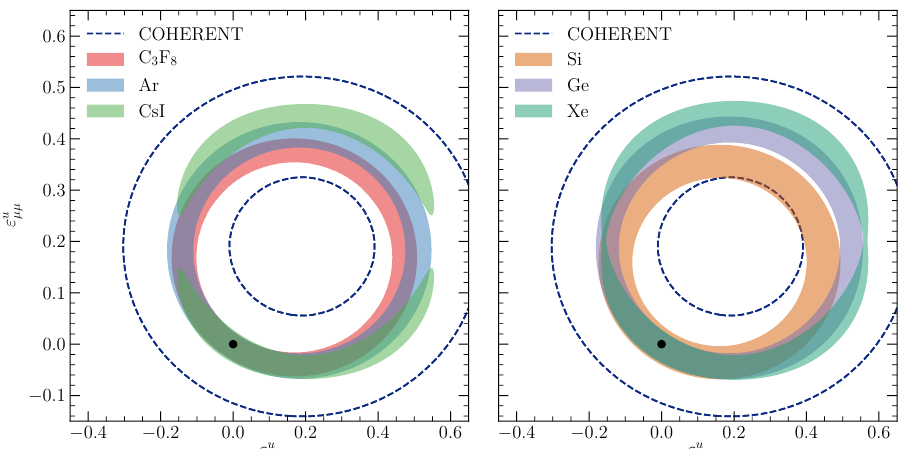
Figure 12 . Expected allowed regions in the ( (cid:15) u;V ; (cid:15) u;V ) plane at the 90% con(cid:12)dence level (C.L.) ee (cid:22)(cid:22) for two degrees of freedom (d.o.f.). The di(cid:11)erent regions correspond to the expected results for the di(cid:11)erent detectors listed in table 1, as indicated by the legend. In all cases, the simulated data has been generated for the SM (that is, setting all the operator coe(cid:14)cients to zero), and the results are then (cid:12)tted assuming NSI. For simplicity, the rest of the NSI parameters not shown in the (cid:12)gure have been assumed to be zero. For comparison, the dashed lines show the allowed regions at 90% CL in this plane, as obtained in ref. [6] from an analysis of current data from the COHERENT experiment [2], see text for